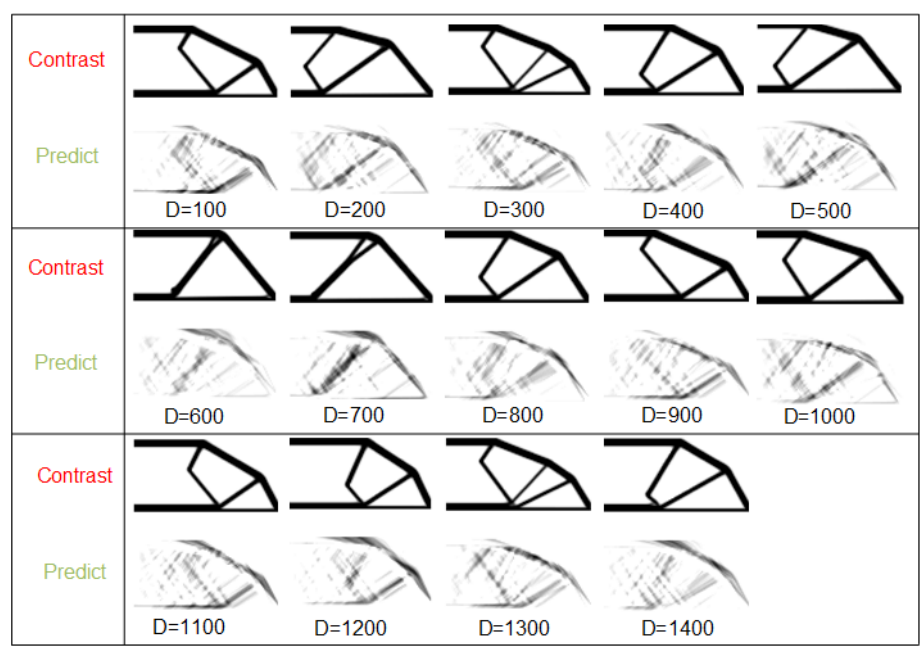
Figure 11. Initial prediction result of training 4 with different